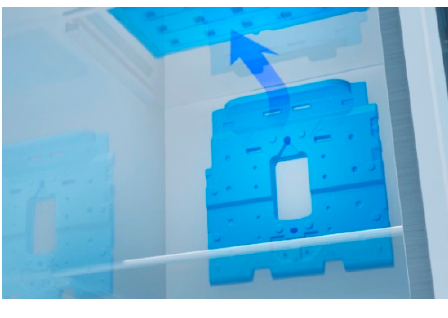
Figure 1. A functional duct unit (FDU) filled with selected PCM in the refrigerator.